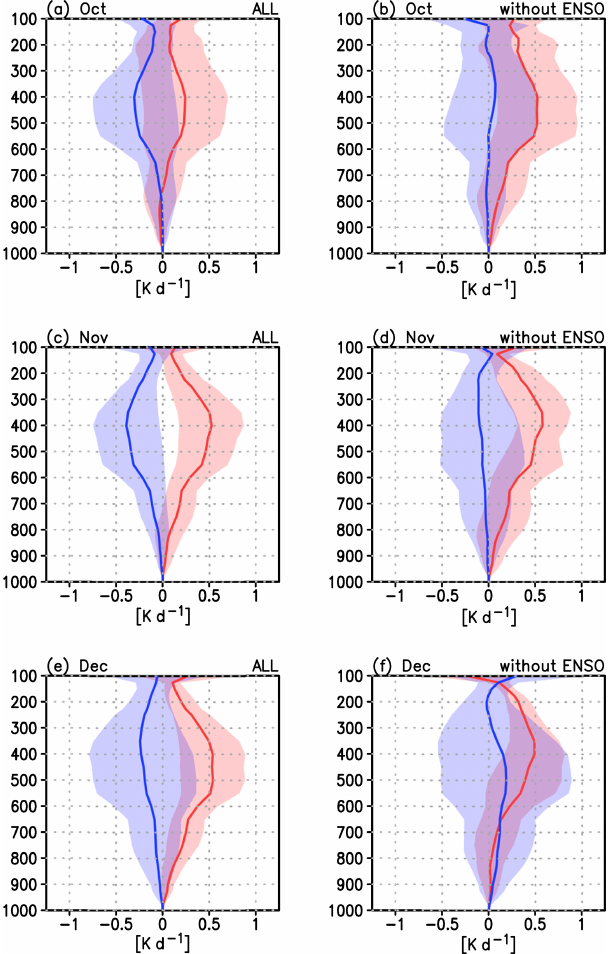
Figure 6. Vertical profiles of diabatic heating in temperature over western tropical Pacific region (0–10 ◦ N, 130–160 ◦ E) derived from the conservation property of potential temperature (see Ap- pendix B). Values are deviation from the climatology. Red lines show EQBO composite and blue lines show WQBO composite. Shadings show twice the standard error, corresponding to the 95% confidence interval. (a) October with ENSO years. (b) October without ENSO years. (c) November with ENSO years. (d) Novem- ber without ENSO years. (e) December with ENSO years. (f) De- cember without ENSO